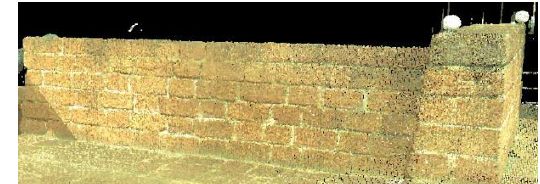
Figure 5. The details of the point cloud data of the monument